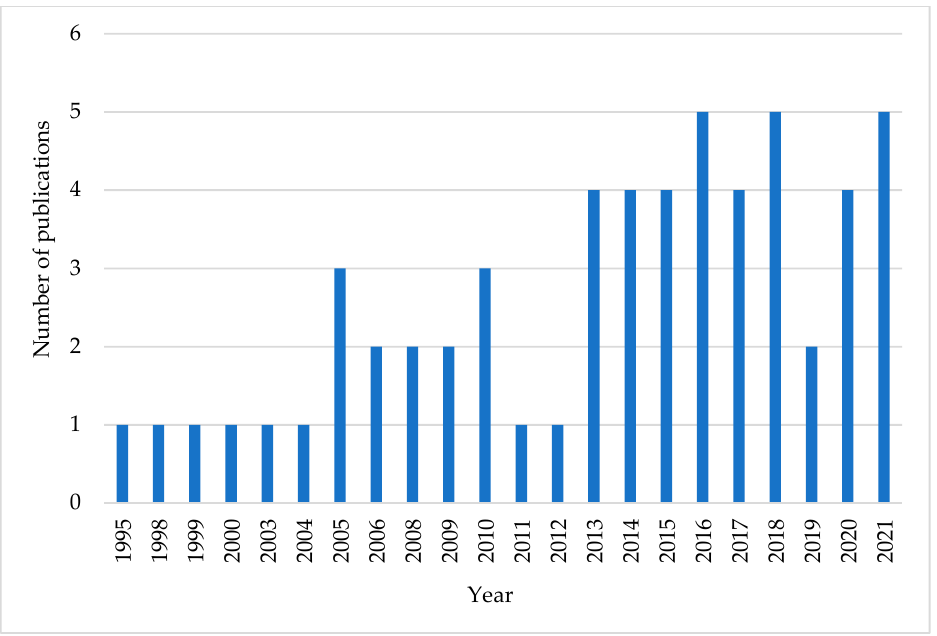
Figure 1. The number of published papers throughout the years used in this work.